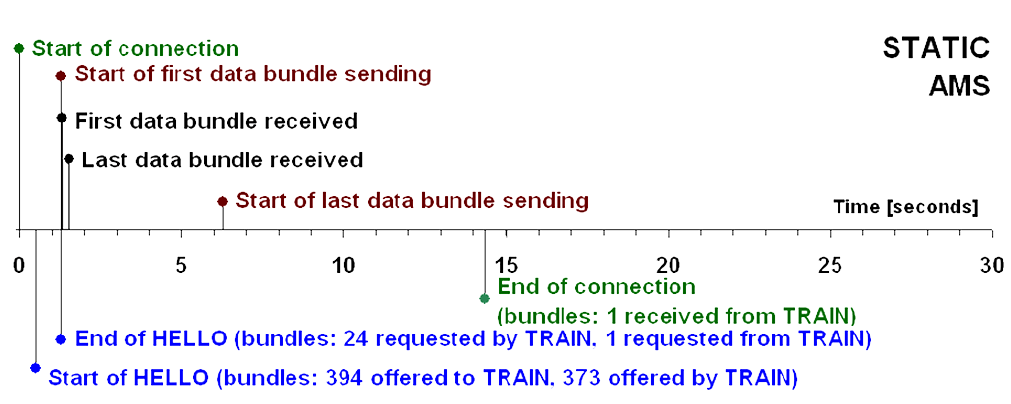
Fig. 11. Timeline of events on the mobile node (horizontal timescale in seconds after the start of connection).